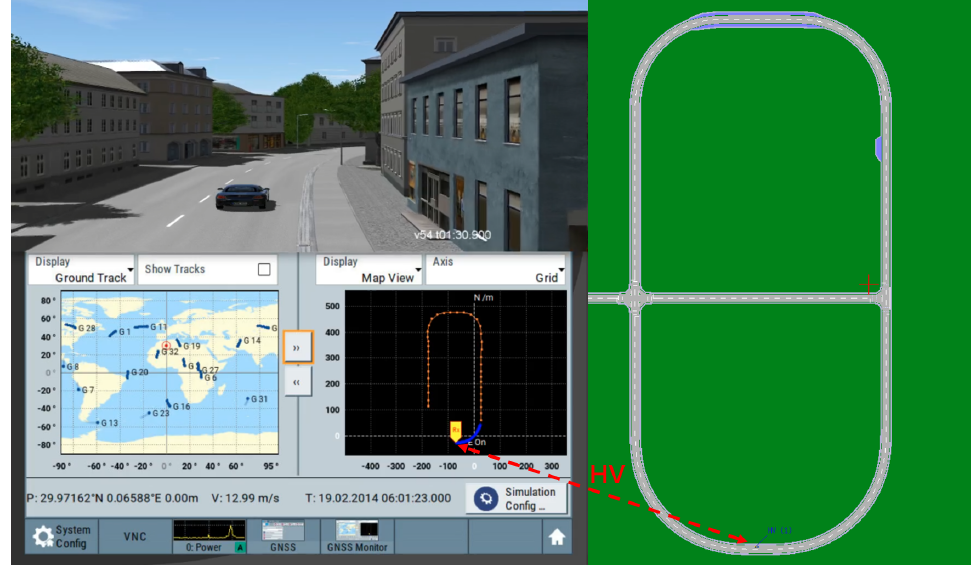
Figure 8. GNSS simulation in VTD